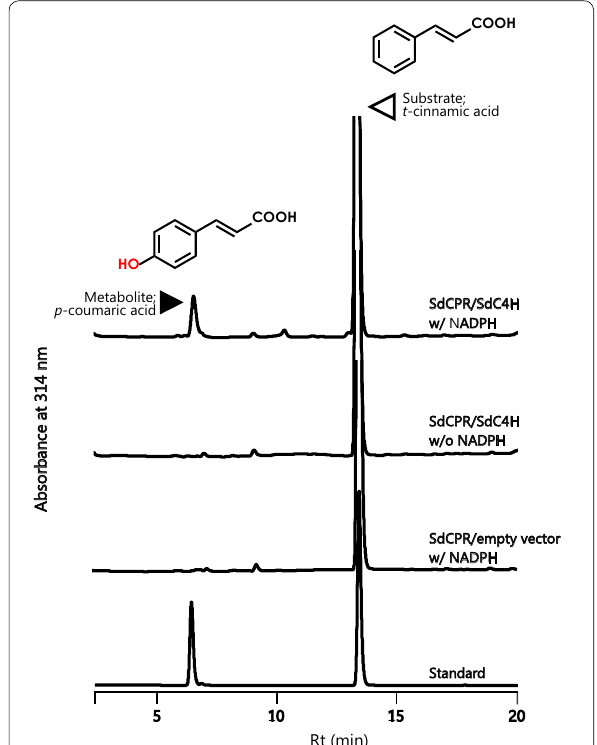
Fig. 3 HPLC analysis of 4-hydroxylase assays. E. coli cell lysates containing recombinant SdCPR and SdC4H (SdCPR/SdC4H) with NADPH (w/NADPH) or without NADPH (w/o NADPH). Empty vector (SdCPR/vector) with NADPH. Authentic standards of p -coumaric acid (Rt 6.5 min) and t -cinnamic acid (Rt 13.0 min) = =